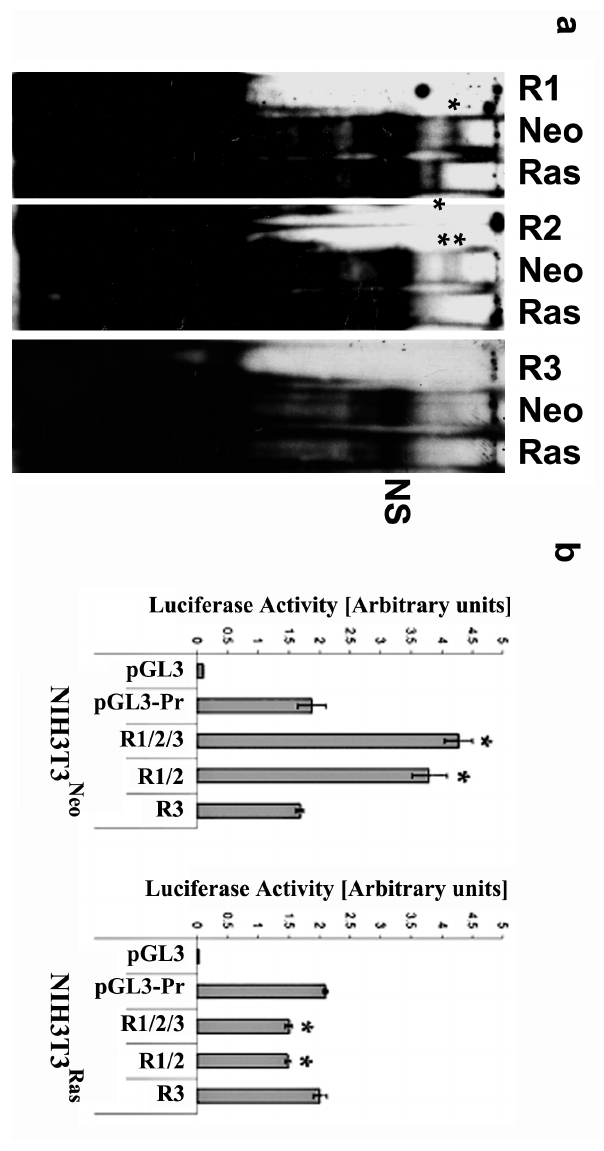
Figure 6. Differential binding of trans-acting factors to regions of the 3 9 UTR S1516. a) REMSA using three different riboprobes (R1, R2 and R3) spanning the S1516 region. Binding reactions were performed with the riboprobes as explained in ‘‘Materials & Methods’’ in the presence of protein extracts from NIH3T3 Neo (Neo) and NIH3T3 Ras (Ras) cells. RNA/proteins complexes are indicated by stars. N.S.: non- specific binding. b) Luciferase assay using the NIH3T3 Neo and NIH3T3 Ras cells, transfected with Cx43 mRNA 3 9 UTR constructs corresponding to the three riboprobes R1, R2 and R3 ( i.e. full length S1516 element, R1/2/ 3), riboprobes 1 and 2 (R1/2) or riboprobe 3 (R3). The experiments were performed at least three times in quadruplicates (* p , 0.05).